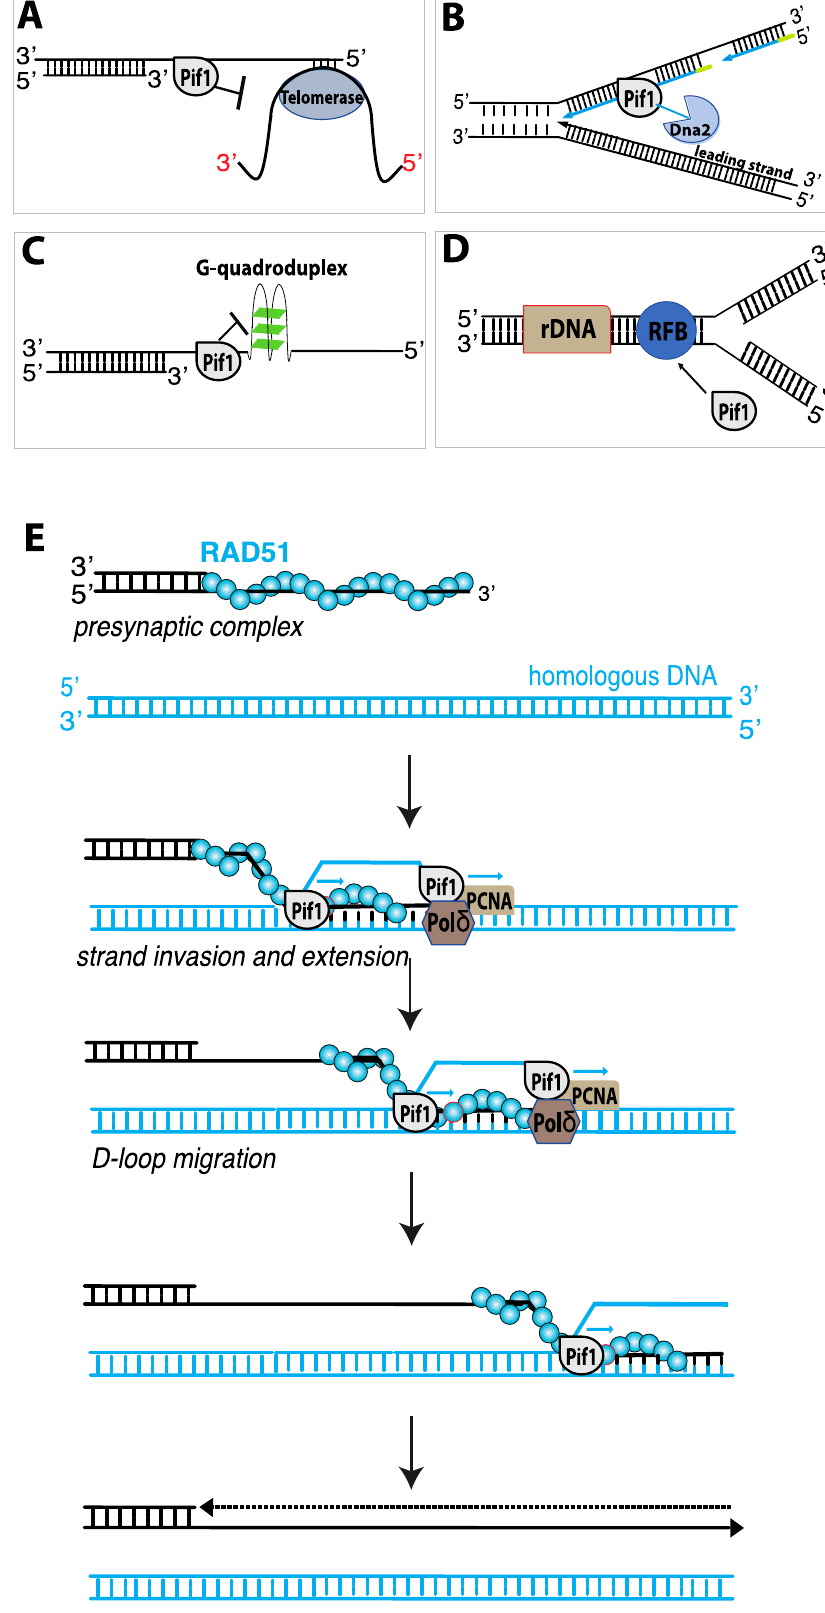
Figure 5. Multifaceted roles for Pif1 in nucleic acid metabolism. ( A ) Pif1 inhibits telomerase-mediated telomere elongation by directly removing telomerase from a DNA end [108]. ( B ) Pif1 contributes